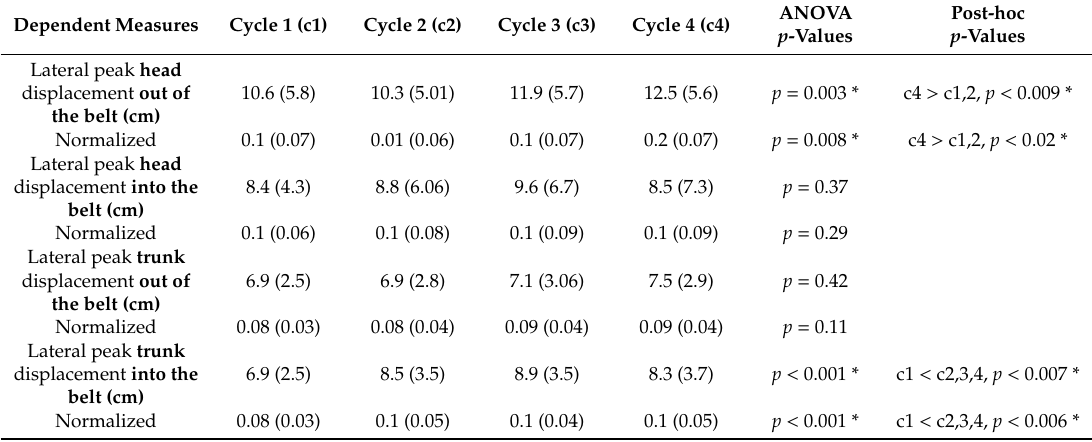
Table 3. Mean (SD) of normalized and non-normalized kinematic outcome measures: e ff ect of cycle. Dependent Measures